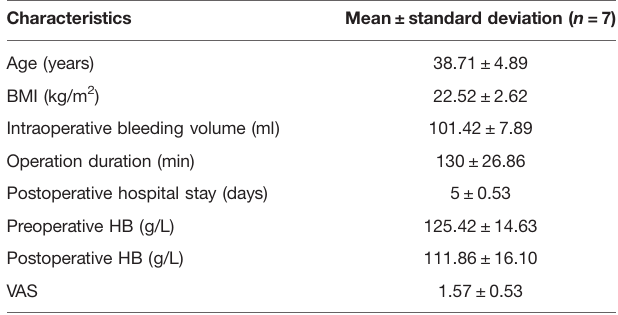
TABLE 1 | Statistical data of the seven